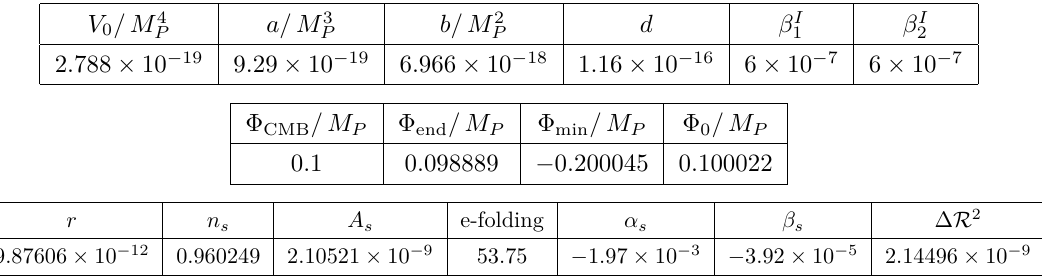
Table 2. Benchmark values for linear term potential (Model I) ( Φ min is the minimum of potential in eq. (2.35)).